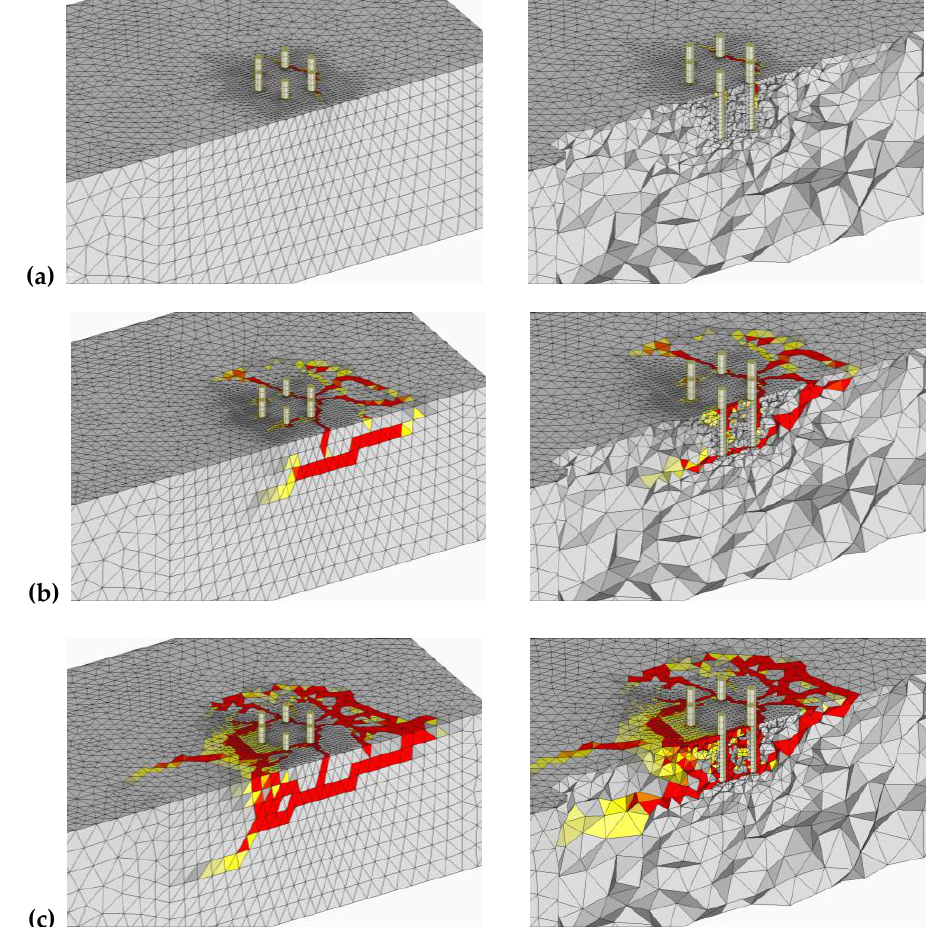
Figure 13. Crack pattern obtained from numerical analysis for Group Hex-A loaded parallel to the edge ( a ) first cracks, ( b ) at peak load, and ( c ) post-peak phase.